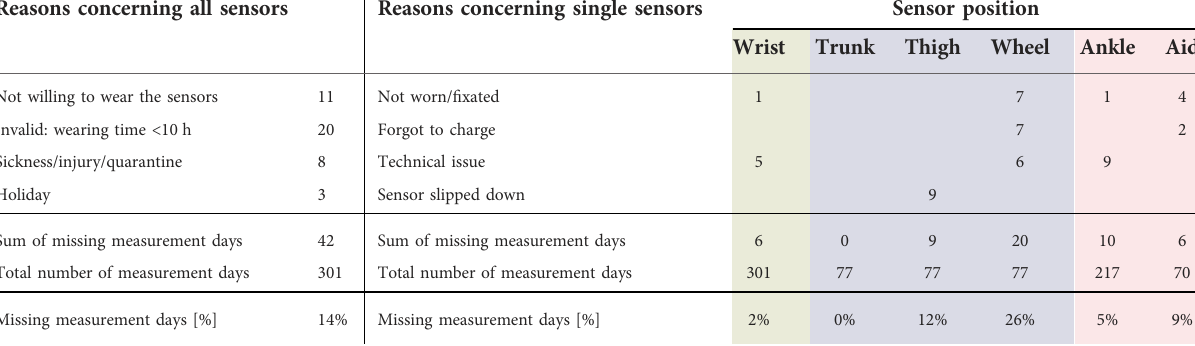
TABLE 3 Numbers and reasons for missing measurement days divided into concerning all sensors at once or a single sensor only. Reasons concerning all